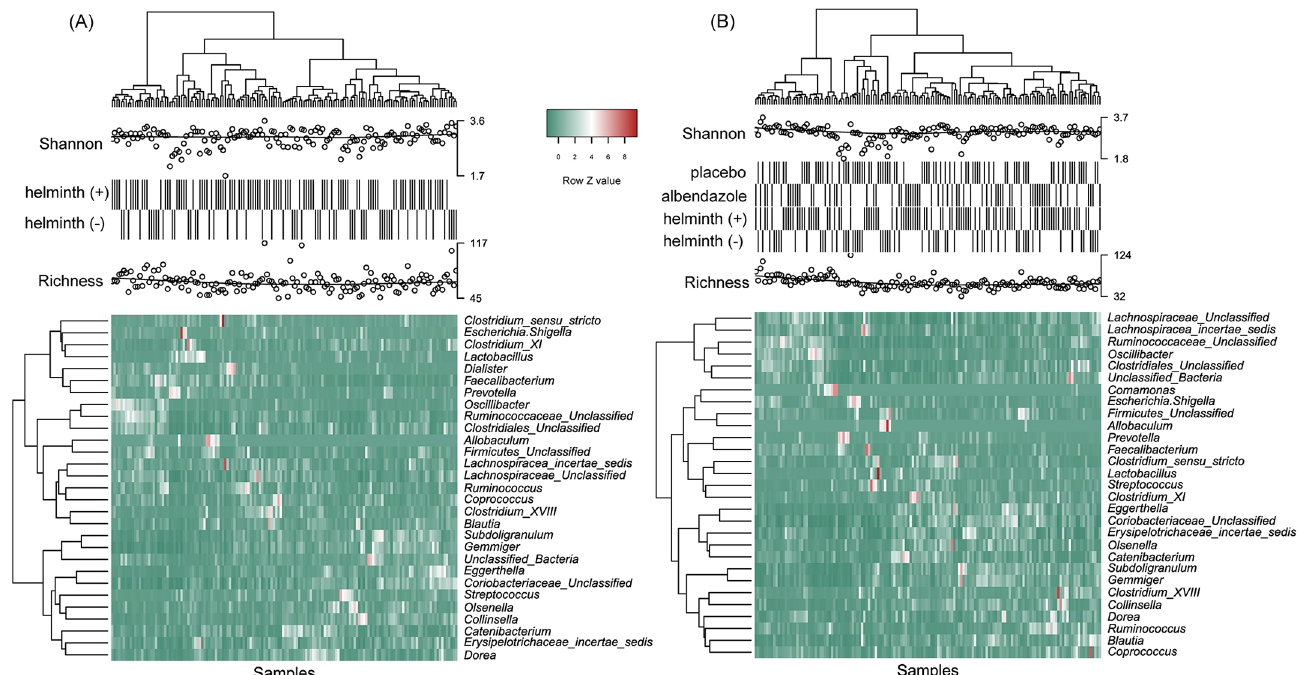
Fig 3. Heatmaps showing the relative abundance of the 29 most abundant genera of each sample at pre-treatment (A) and post-treatment (B). Each column in the heatmap represents a specific sample and each row represents a genera. Colors represent the scaled relative abundance of genera with green and red representing low and high abundance, respectively. Samples and genera were clustered hierarchically (using the Ward method [38]) based on Euclidean distance of the relative abundance profiles and were depicted on the top and left dendrogram, respectively. The infection status, treatment allocation, Shannon and richness indices for all samples were annotated above the heatmap. Circles in Shannon and richness represents the diversity indices for each sample. There is no clustering of samples or genera based on infection or treatment status.